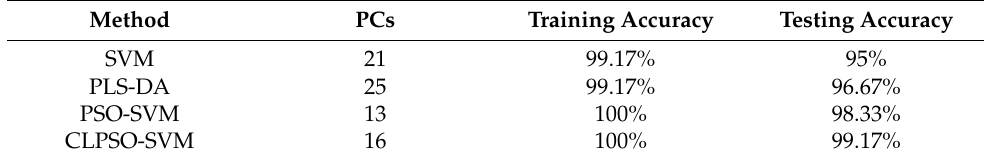
Table 1. Comparison of four methods.